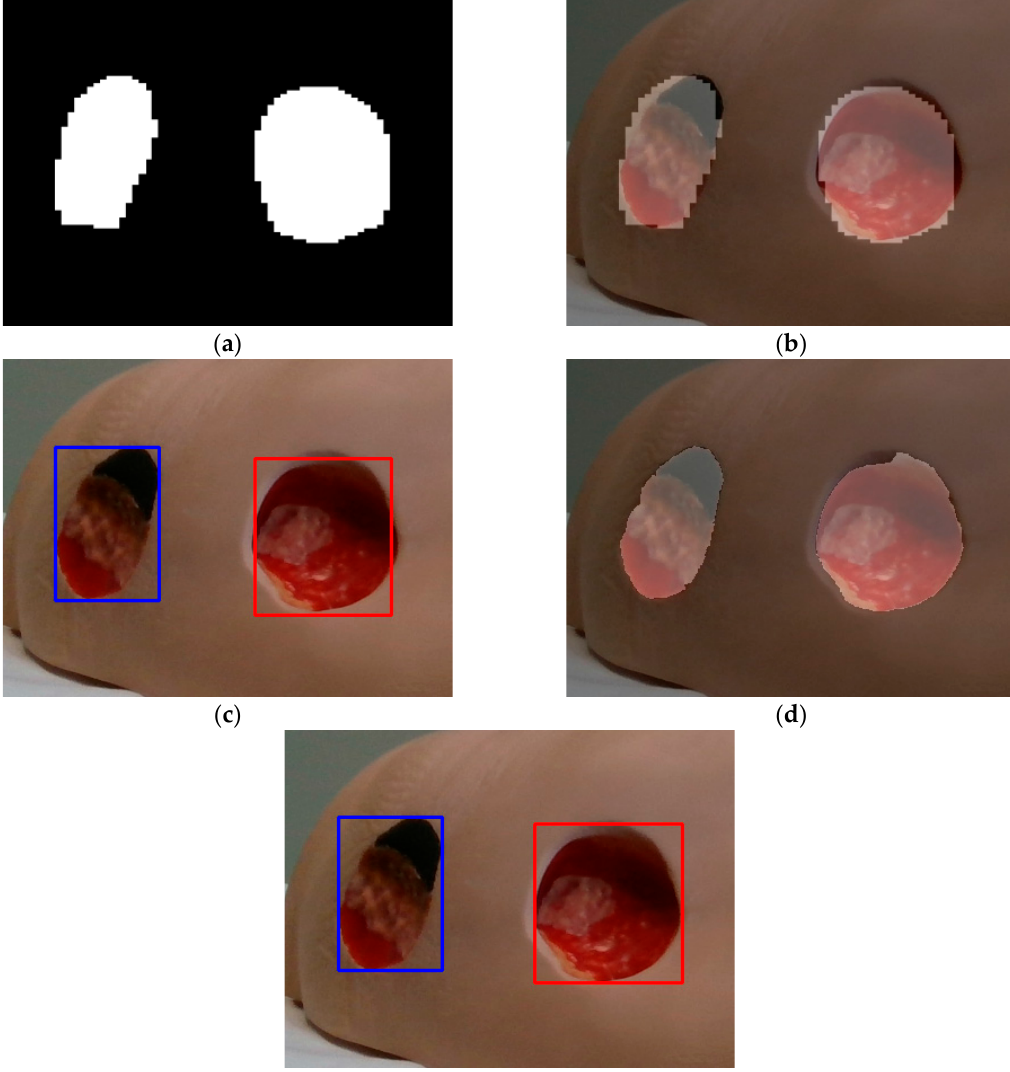
Figure 6. Enlarged section of the original test image under consideration: ( a ) output binary image obtained as a result of the method proposed by Wang et al. [10]; ( b ) wound pixels marked on the original image; ( c ) corresponding region of interests (ROIs) of image ( b ) where blue and red denotes di ff erent wounds; ( d ) wound pixels marked on the original image after additional post-processing using GrabCut; ( e ) corresponding ROIs of image ( d ) where blue and red denotes di ff erent wounds.